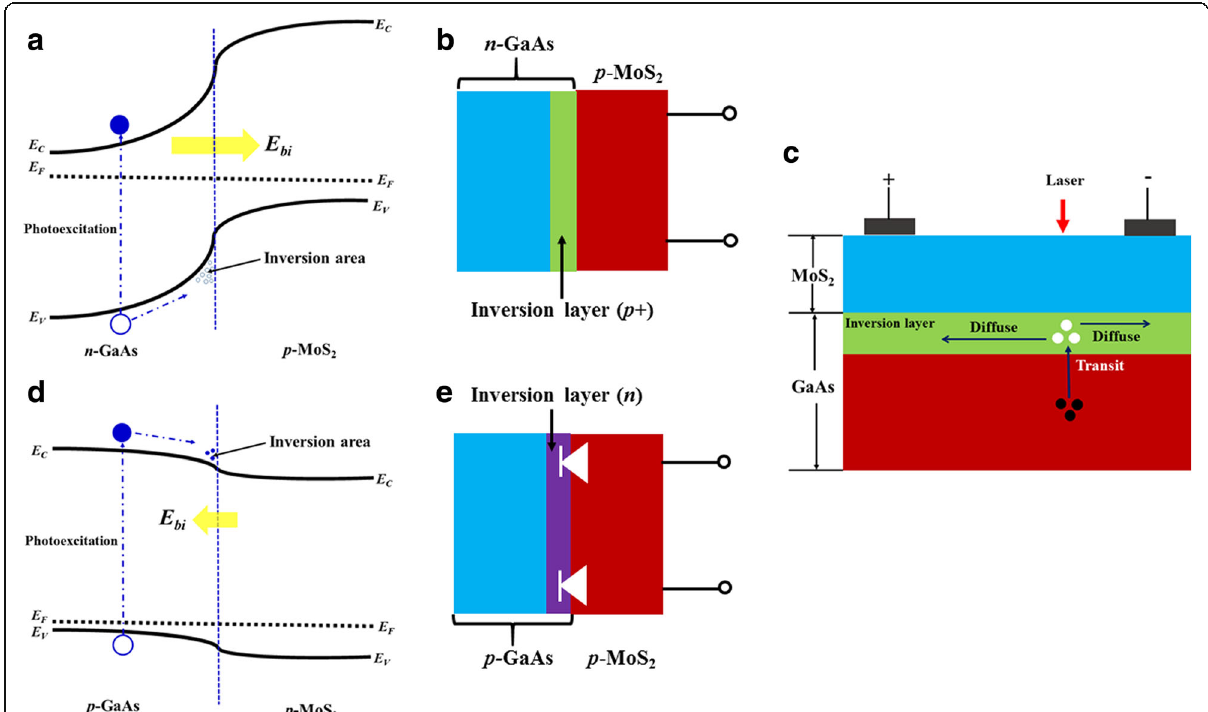
Fig. 7 a Energy-band alignment of the MoS 2 / n -GaAs heterojunction, and b the corresponding illustration of the electrical contacting at the interface. c Mechanism of the LPE in the MoS 2 / n -GaAs heterojunction. d Energy-band alignment of the MoS 2 / p -GaAs heterojunction, and e the corresponding illustration of the electrical contacting at the